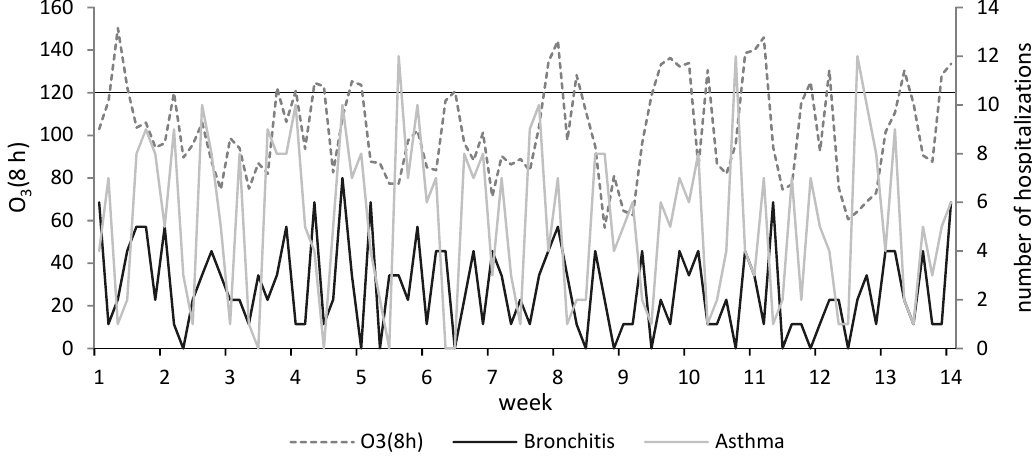
Figure 1. Daily ozone concentrations and the number of hospitalizations due to asthma and bronchitis in summer 2017.